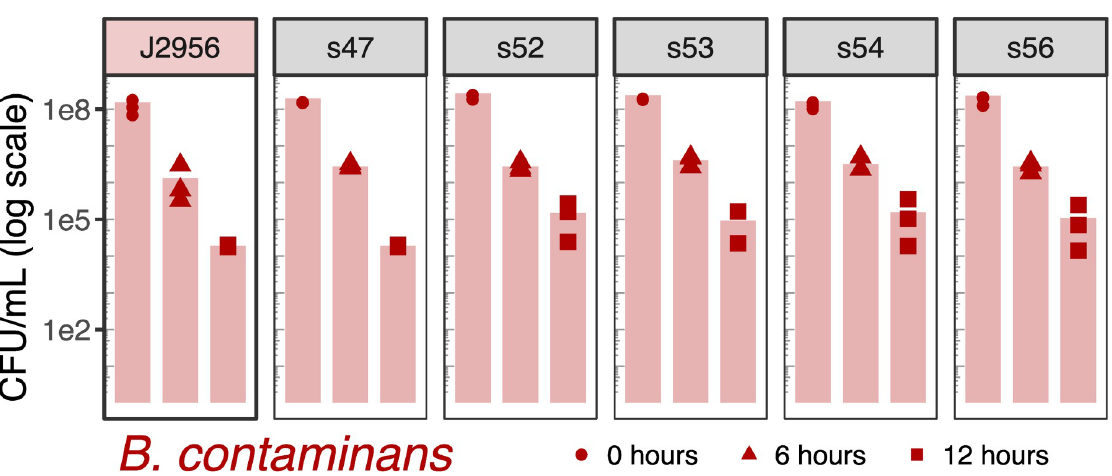
Fig 7. B . contaminans colony forming units per milliliter (CFU/mL) following addition of J774A.1 mouse macrophage. Same as Fig 6, but here for B . contaminans . As compared to the reference strain via two-sided t-tests, none were found to have an adjusted p-value < 0.99 (adjusted by Bonferonni